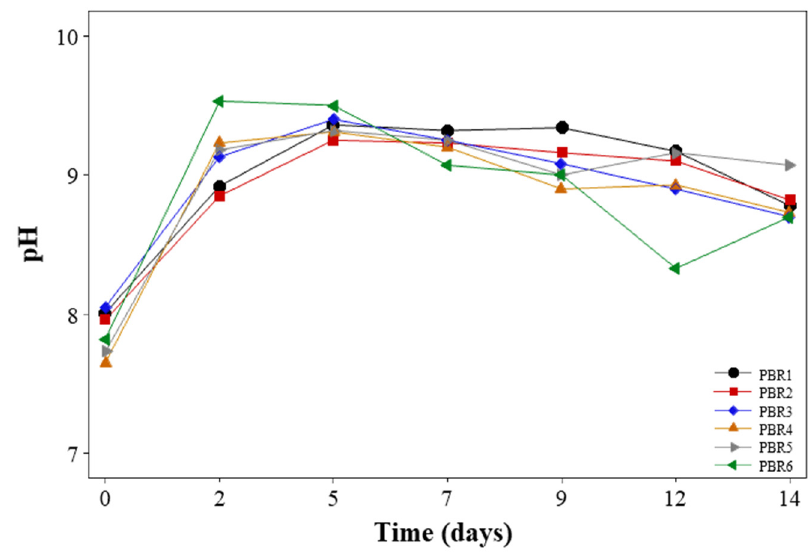
Figure 2. Variation of pH in photobioreactors during operation .